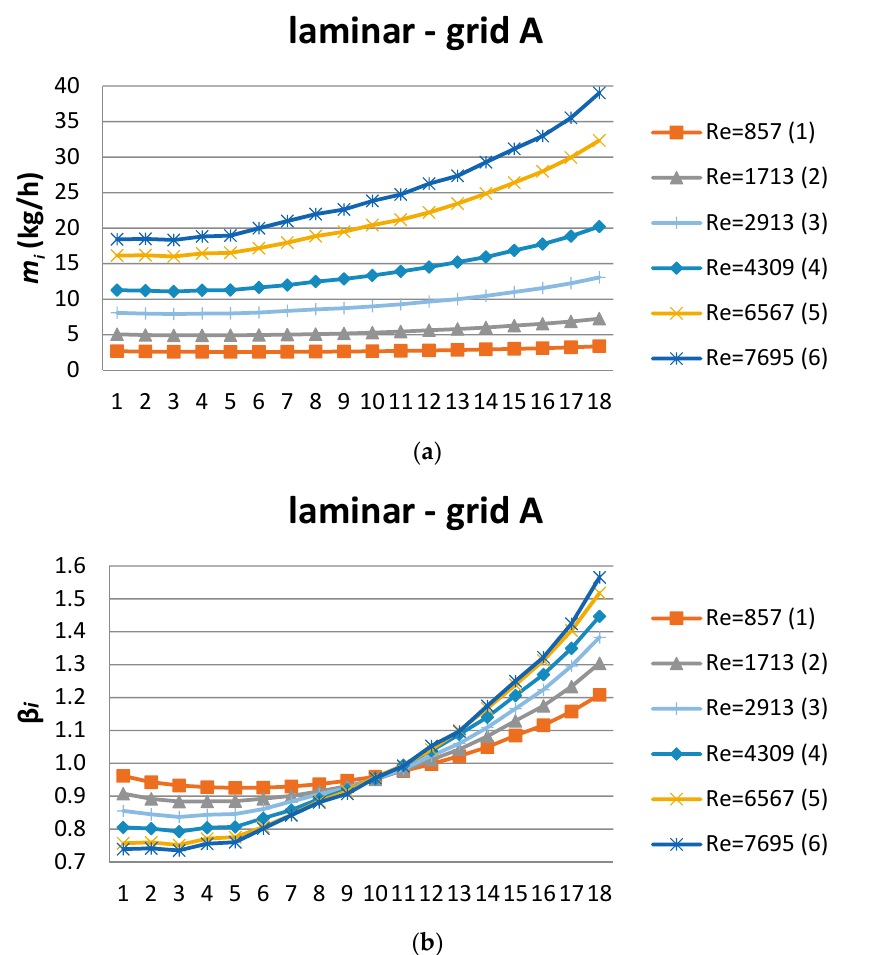
Figure 9. Numerical prediction of flow distribution in riser tubes for various inlet Reynolds numbers. ( a ) Mass flow rate; ( b ) Non-dimensional local to average flow rate ratio.